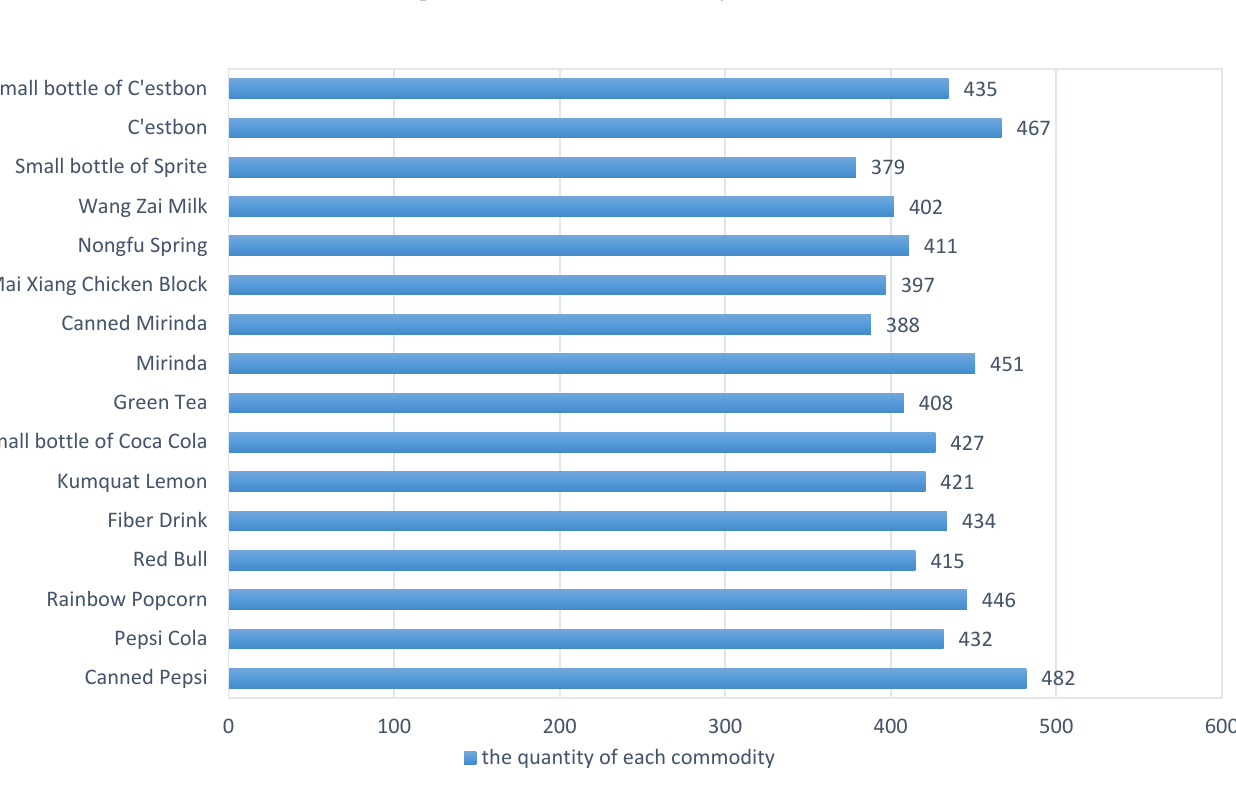
Figure 8. Sample datasets of each commodity.